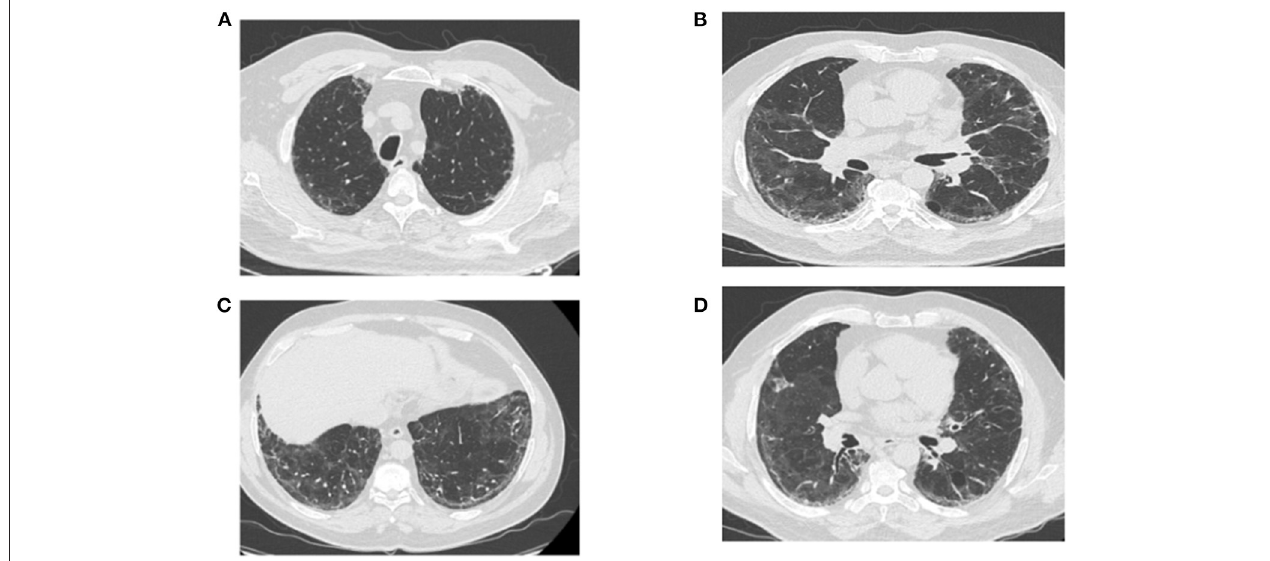
FIGURE 3 | Post-corticotherapy chest CT scan (third chest CT scan). The chest CT scan performed after 3 months of corticotherapy of post-COVID-19 symptoms reveals the regression of ground-glass lesions and bronchiectasis, and the persistence of paracicatricial emphysema (A–C) . (B–D) Show the disappearance of the cavity image of the right middle lobe, the regression of retraction signs, and the persistence of few reticulation